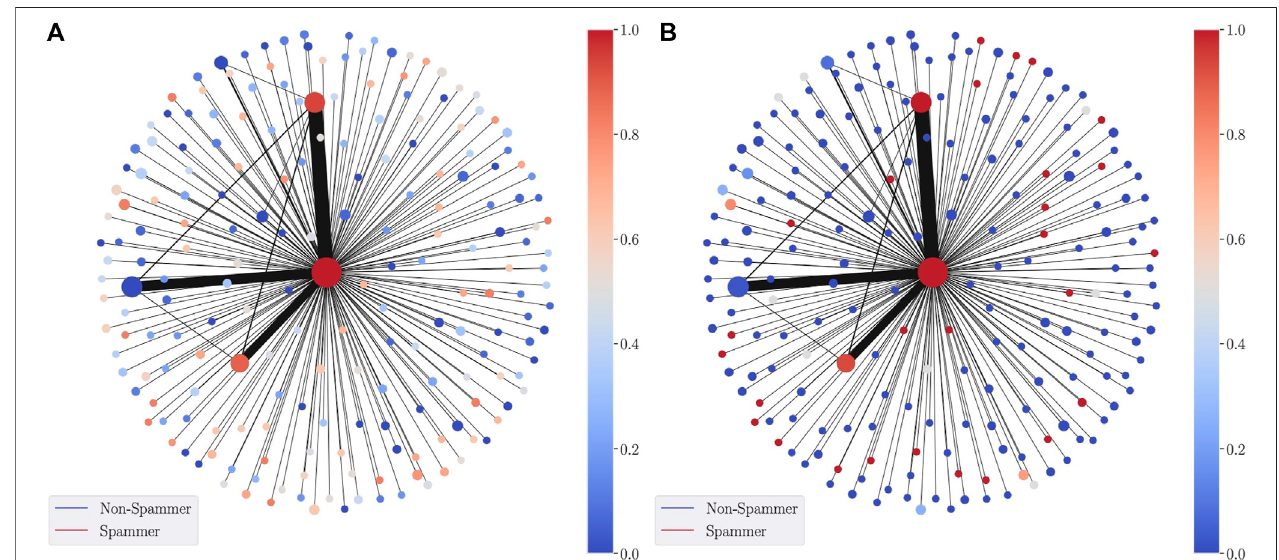
FIGURE 3 | SDGM visualization using as a lens function the GNN-predicted probability of a node in the network to be Spam. The (A) is colored with the average predicted spam probability in each cluster, whereas the (B) is colored by the proportion of true spammers in each